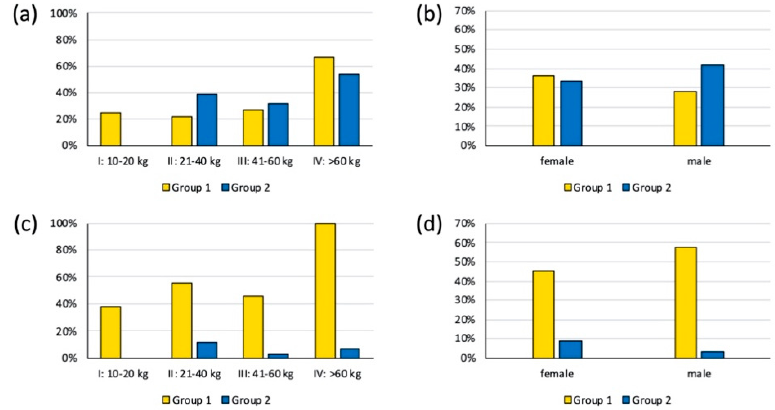
Figure 2. Seroprevalence of Toxoplasma gondii and Salmonella in hunted wild boars from two regions in Switzerland. Group 1: animals originating from the wild boar population in northern Switzerland; group 2: animals from southern Switzerland. ( a ) Percent of T. gondii -seropositive wild boars belonging to different weight categories; ( b ) percent of T. gondii -seropositive wild boars among female and male animals.; ( c ) percent of Salmonella -seropositive wild boars belonging to different weight categories; ( d ) percent of Salmonella seropositive wild boars among female and male animals.